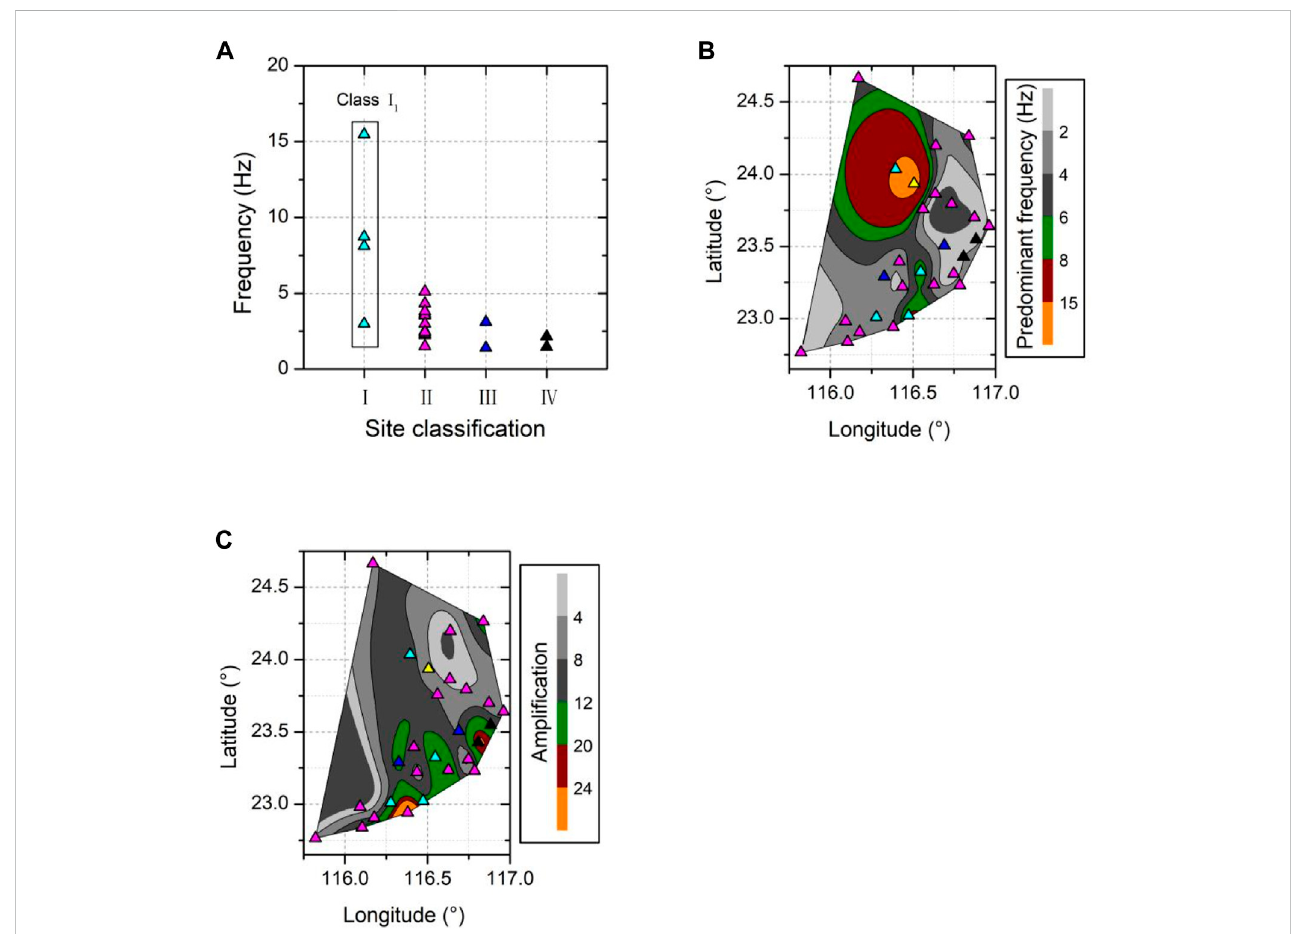
FIGURE 11 (A) Distribution of site classi fi cation vs. predominant frequency. (B) Predominant frequency distribution of stations. (C) Geographical distribution of site ampli fi